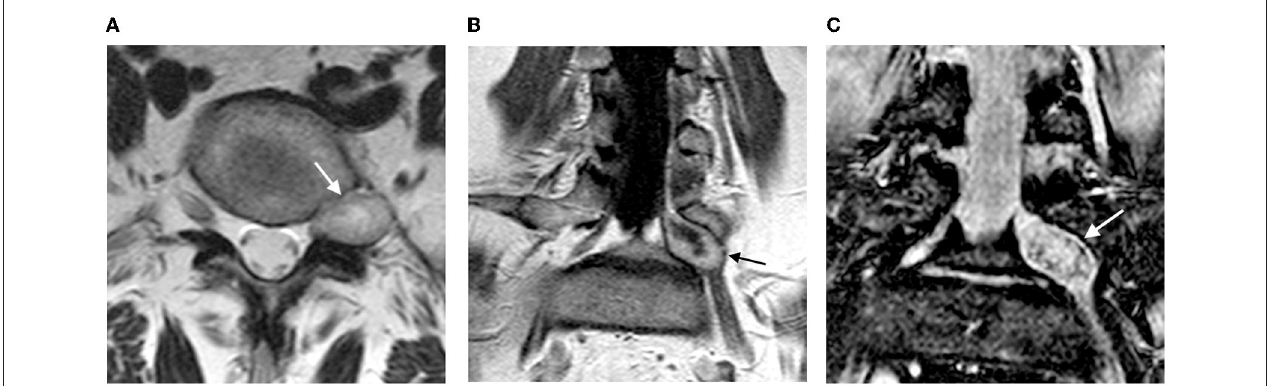
FIGURE 1 | Magnetic resonance imaging of the lumbar spine: (A) axial view, T2-WI mode; (B) frontal view, T1-WI contrast mode; (C) frontal view, T1-FS post-contrast (arrow shows a cystic-solid tumor of the spinal nerve, size 3.2 × 1.5 × 1.5cm; the tumor accumulates